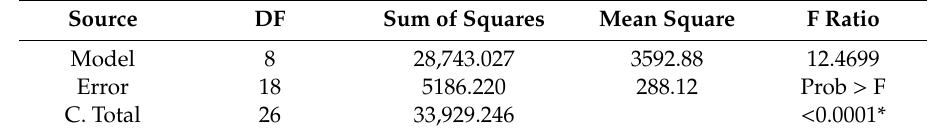
Table 7. ANOVA results for yield strength ( α = 0.05).